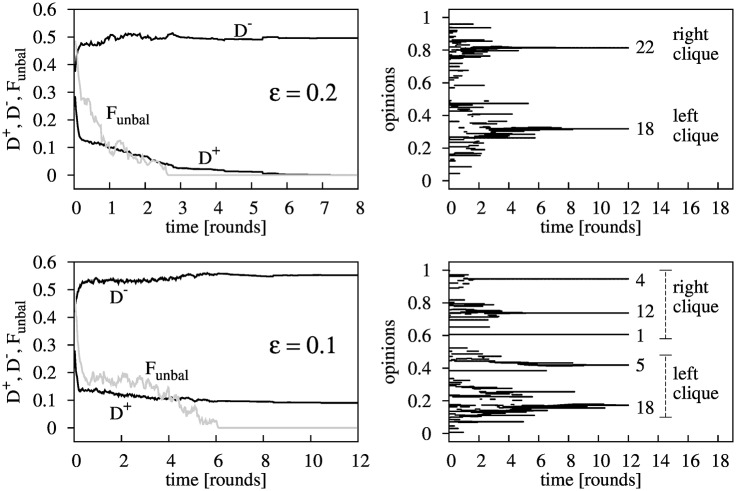
Evolution for a 40 agents system with p = 0.1 and either ε = 0.2 (upper panels) or ε = 0.1 (bottom panels).The two cases shown correspond to a particular run converging to social balance in few rounds; ∼3 rounds in the case with ε = 0.2 and ∼6 rounds in the case with ε = 0.1. Time is given in round units. Left panels show the evolution of the intra-clique opinion diversity D+, the inter-clique opinion separation D− and the fraction of unbalanced triads Funbal. Right panels show the corresponding evolution of the opinions. The labels indicate the number of agents having the same final opinion. In the case with ε = 0.2 all the agents in a clique share the same opinion (intra-clique consensus D+ = 0). In the case with ε = 0.1 opinions converge to 5 different values in ∼10 rounds. Agents in the “left clique” are grouped into two opinion clusters (of 18 and 5 agents), and agents in the “right clique” are grouped into three clusters (of 1, 12 and 4 agents). Within each cluster there is consensus of opinions.